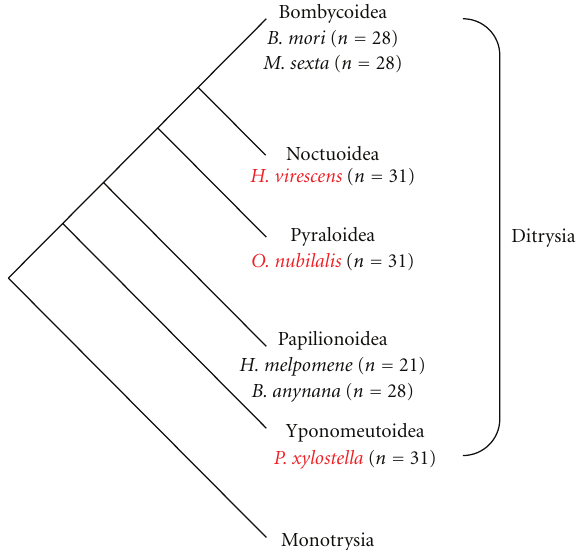
Figure 1: Schematic representation of phylogeny of Lepidoptera and haploid chromosome numbers of species referred to in the text. The phylogeny is based on the studies of Regier et al. [18]. Neither Bombycoidea nor Noctuidae are monophyletic, but form a clade clearly distinguishable from Pyraloidea and butterflies including Papilionoidea